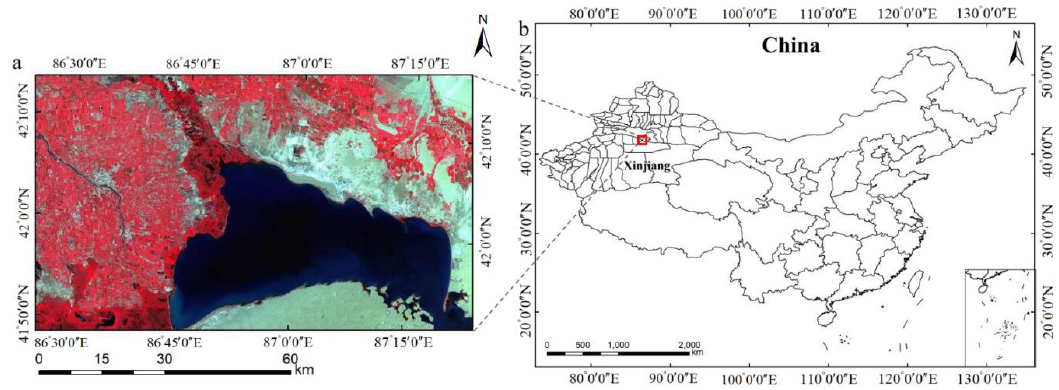
Figure 1. ( a ) Bosten Lake and ( b ) administrative boundary of China.